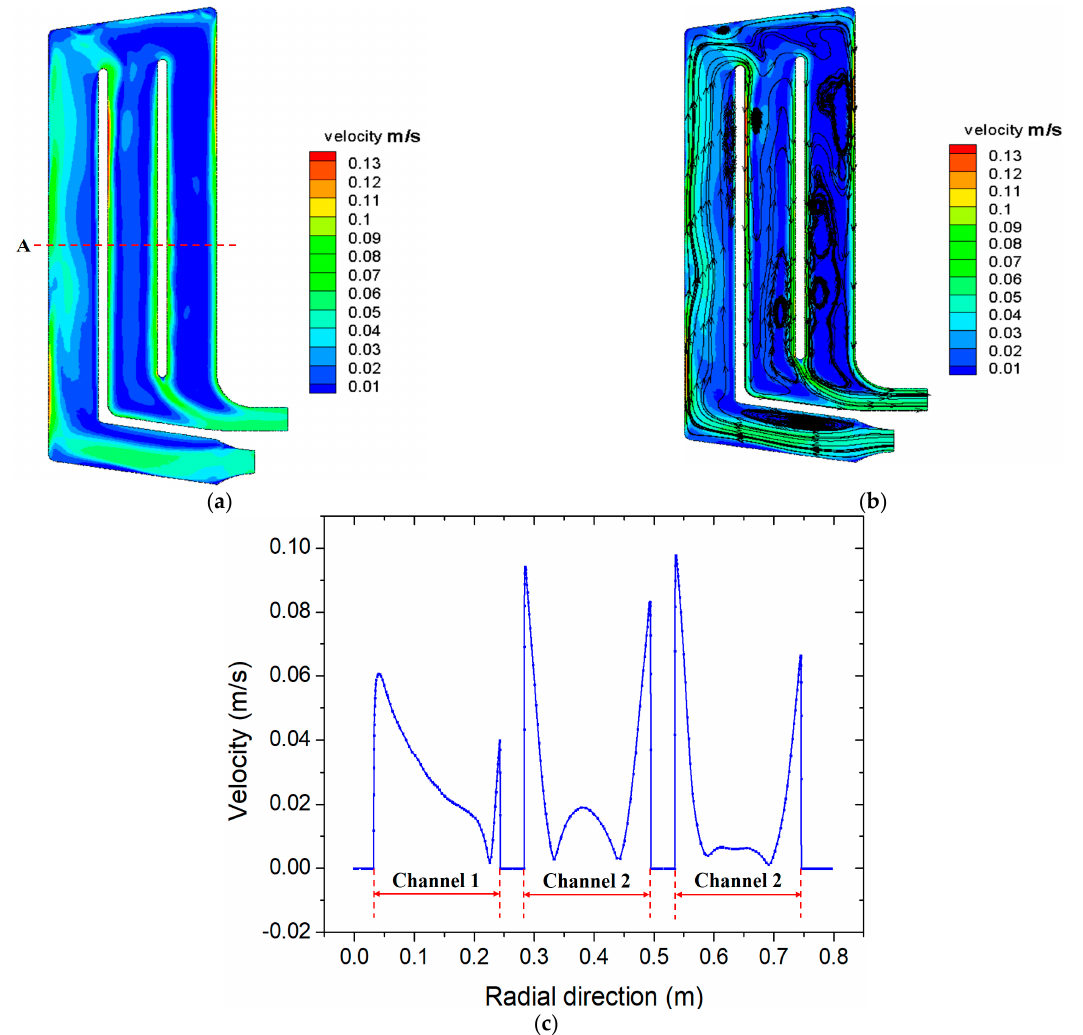
Figure 7. Velocity field ( a ) contour of magnitude; ( b ) streamline; ( c ) radial distribution of velocity magnitude.